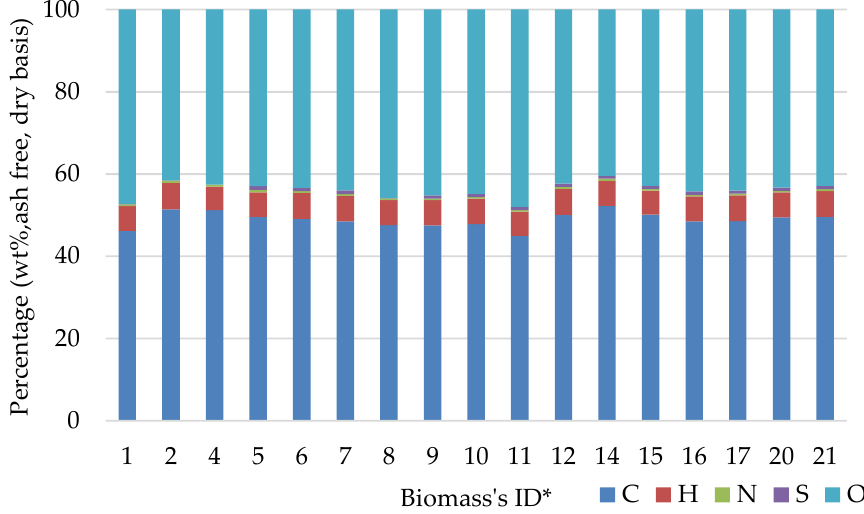
Figure 3. Results of ultimate analysis for Amazonian biomasses (wt. %, ash-free, dry basis). * Biomass identification.